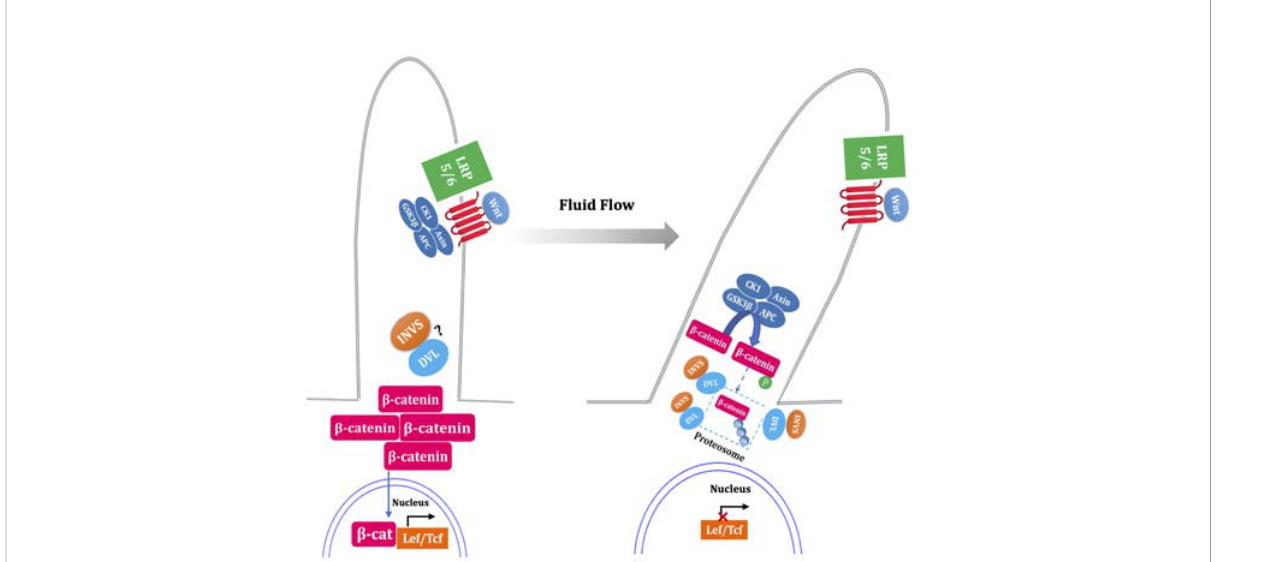
FIGURE 3 Fluid fl ow fl ip the switch from canonical to noncanonical Wnt signaling pathway. In the absence of fl ow, ligand binding with the Frizzled and LRP5/6 complex results in the inactivation of the b -catenin destruction complex (GSK3 b , CK1, APC, Axin), led to stabilization of cytoplasmic b - catenin, which translocate to nucleus and coactivate the transcription level of LEF-TCF family. Fluid fl ow stimulated primary cilia, which is thought to increase the expression of inversin (INVS) and then reduce the cytoplasmic levels of dishevelled (DVL) by increasing its proteasomal degradation pathway. This process is deemed as switch off canonical signal pathway due to the activation of b -catenin destruction complex. The question mark indicate uncertainty as to the INVS-DVL complexes localization. The dotted box mark indicate that whether b -catenin is phosphorylated and ubiquitylated within the cilium is unknown.